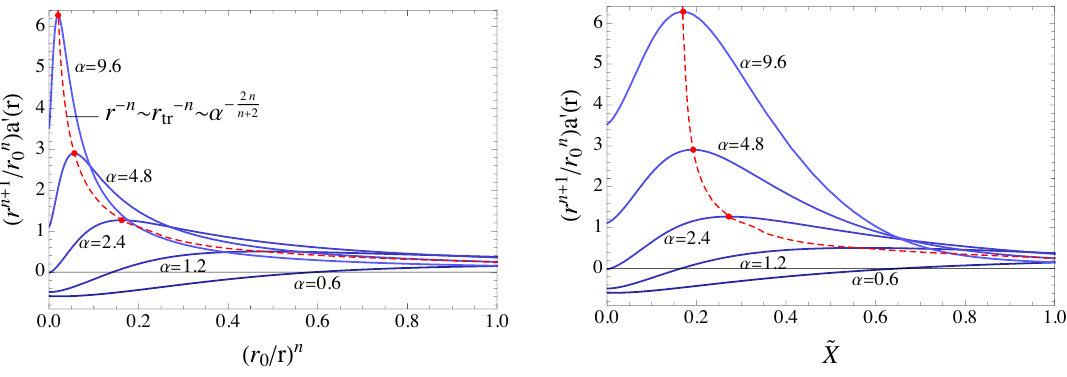
Figure 3 . Appearance of the transition scale r tr in the metric function. The red dashed curves are the peak position for each α . In the right panel, one can see that another coordinate e X keeps the transition region in the center area for better resolution at larger α